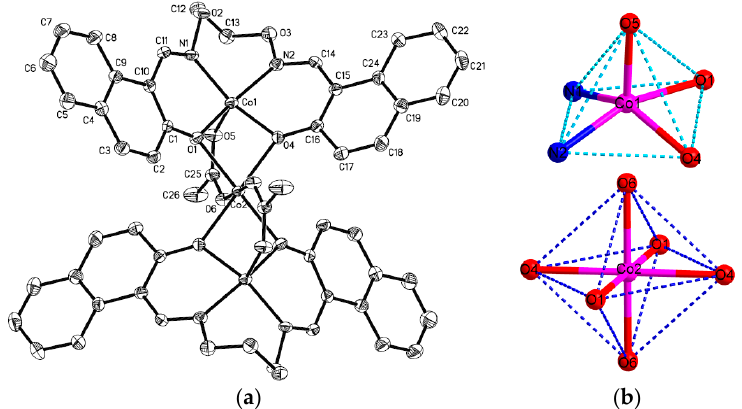
Figure 4. ( a ) View of the coordination environment of Co(II) center with thermal ellipsoids at 30% probability in 2 with a labelling scheme (all H atoms have been omitted for clarity); ( b ) The coordination polyhedron of Co(II) in 2 . Table 3. Selected bond distances (Å) and angles (°) for complexes 1 and 2 .